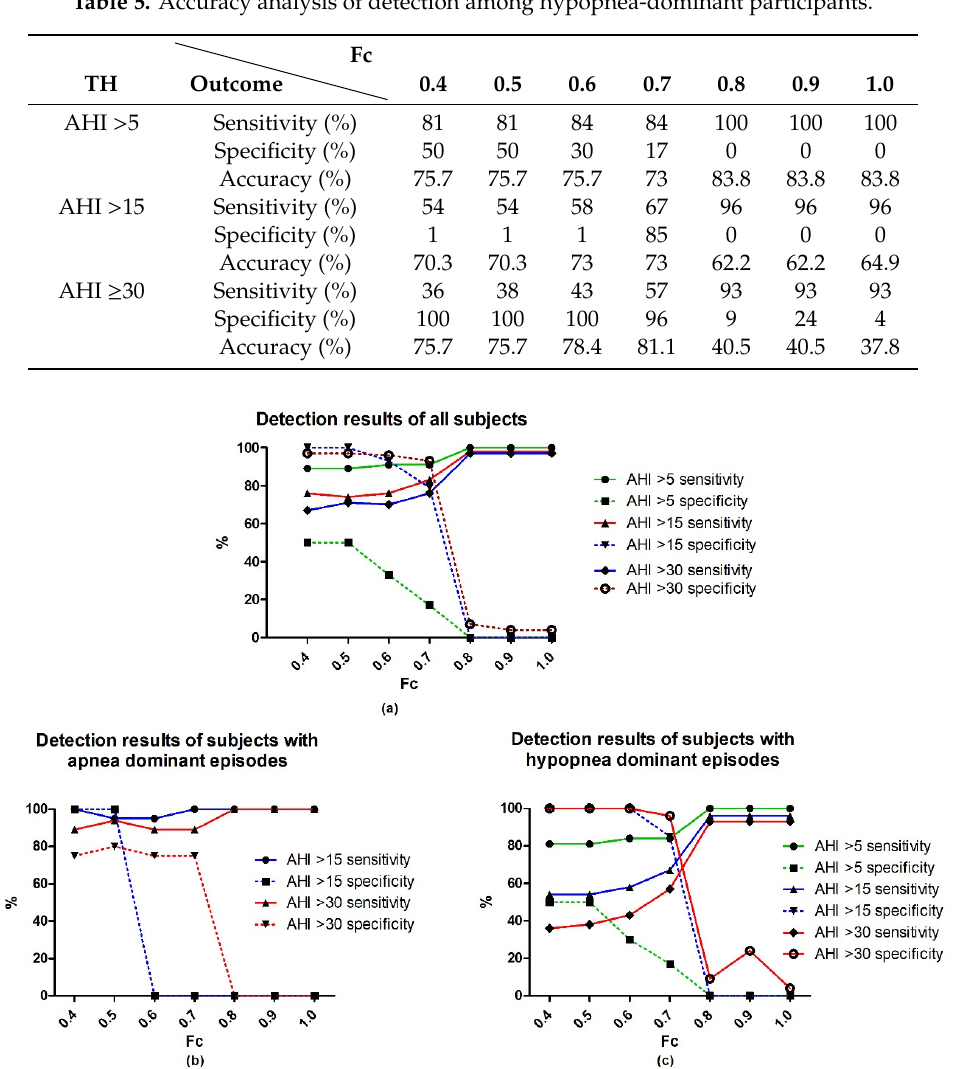
Table 5. Accuracy analysis of detection among hypopnea-dominant participants.